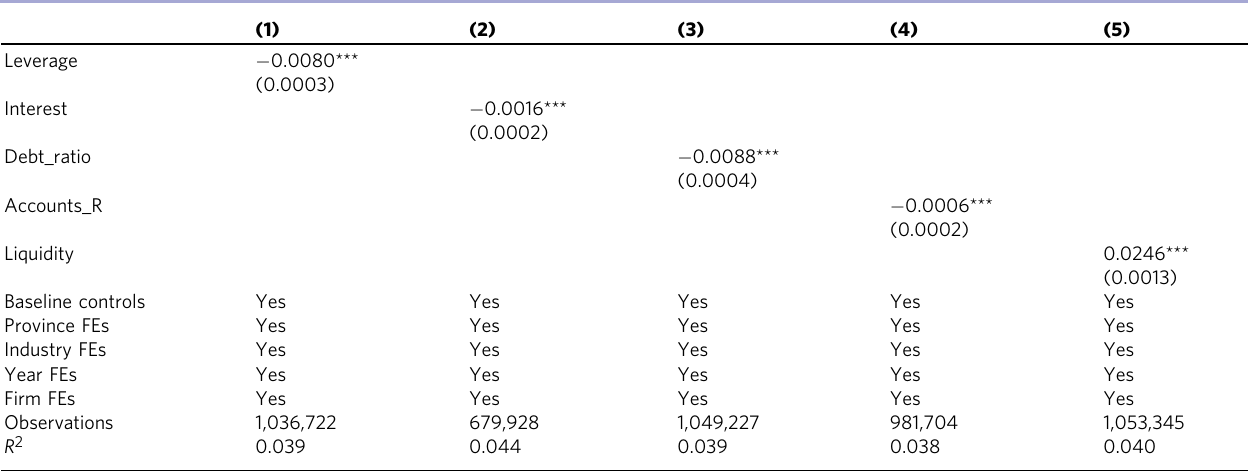
Table 7 Alternative measures for fi nancial constraints.